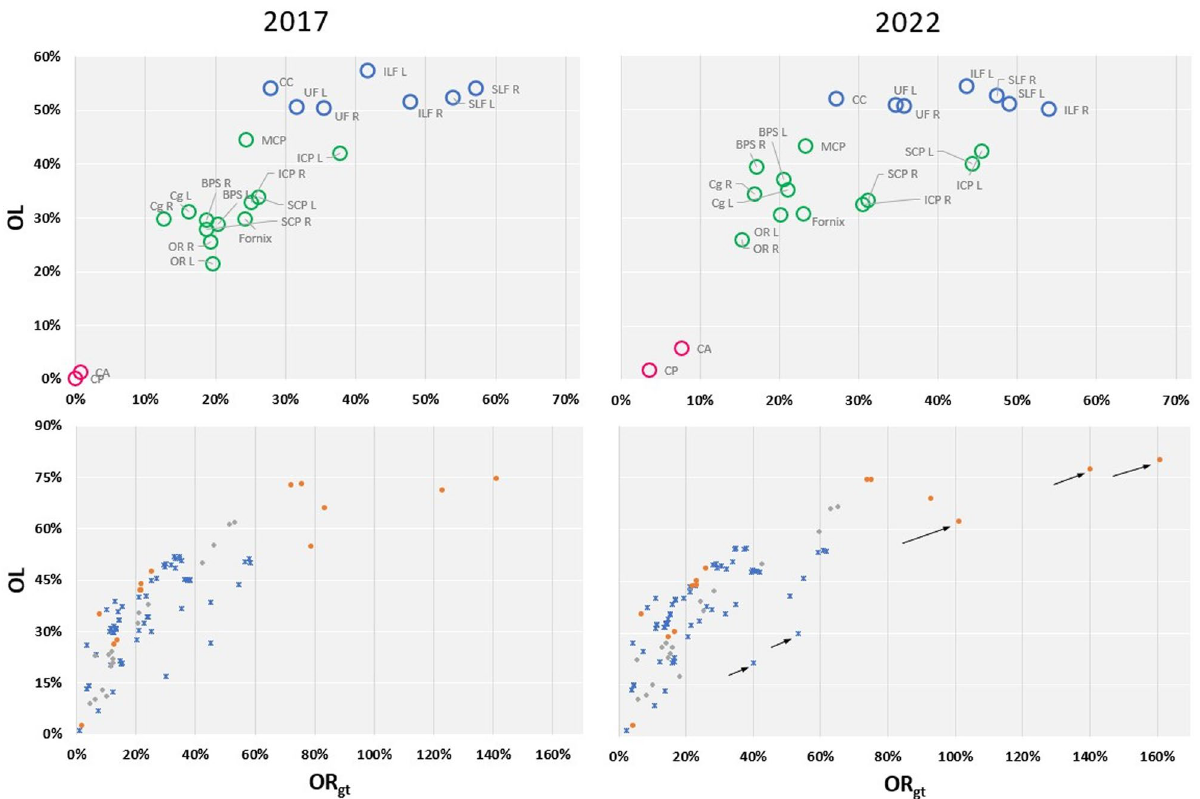
Figure 5. Overlap (OL) vs Overreach (OR gt ) scores in 2022 versus 2015 (with updated masks). Best results should have high overlap (top) and low overreach (left). Top graphs: scores per bundle (averaged over all teams). Colors reflect the differences between easy (blue), average (green) and hard-to-track (pink) bundles, as in 4 . Bottom graphs: scores per submission (averaged over all bundles). Colors reflect the algorithm choice: deterministic (blue), probabilistic (orange) or others (gray). Arrows highlight the displacement of some submissions with strongly changed scores (generally, better OL, worst OR gt